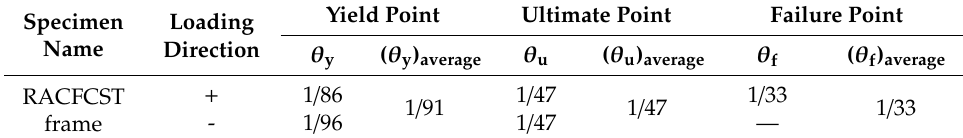
Table 6. Measured displacement angle at characteristic